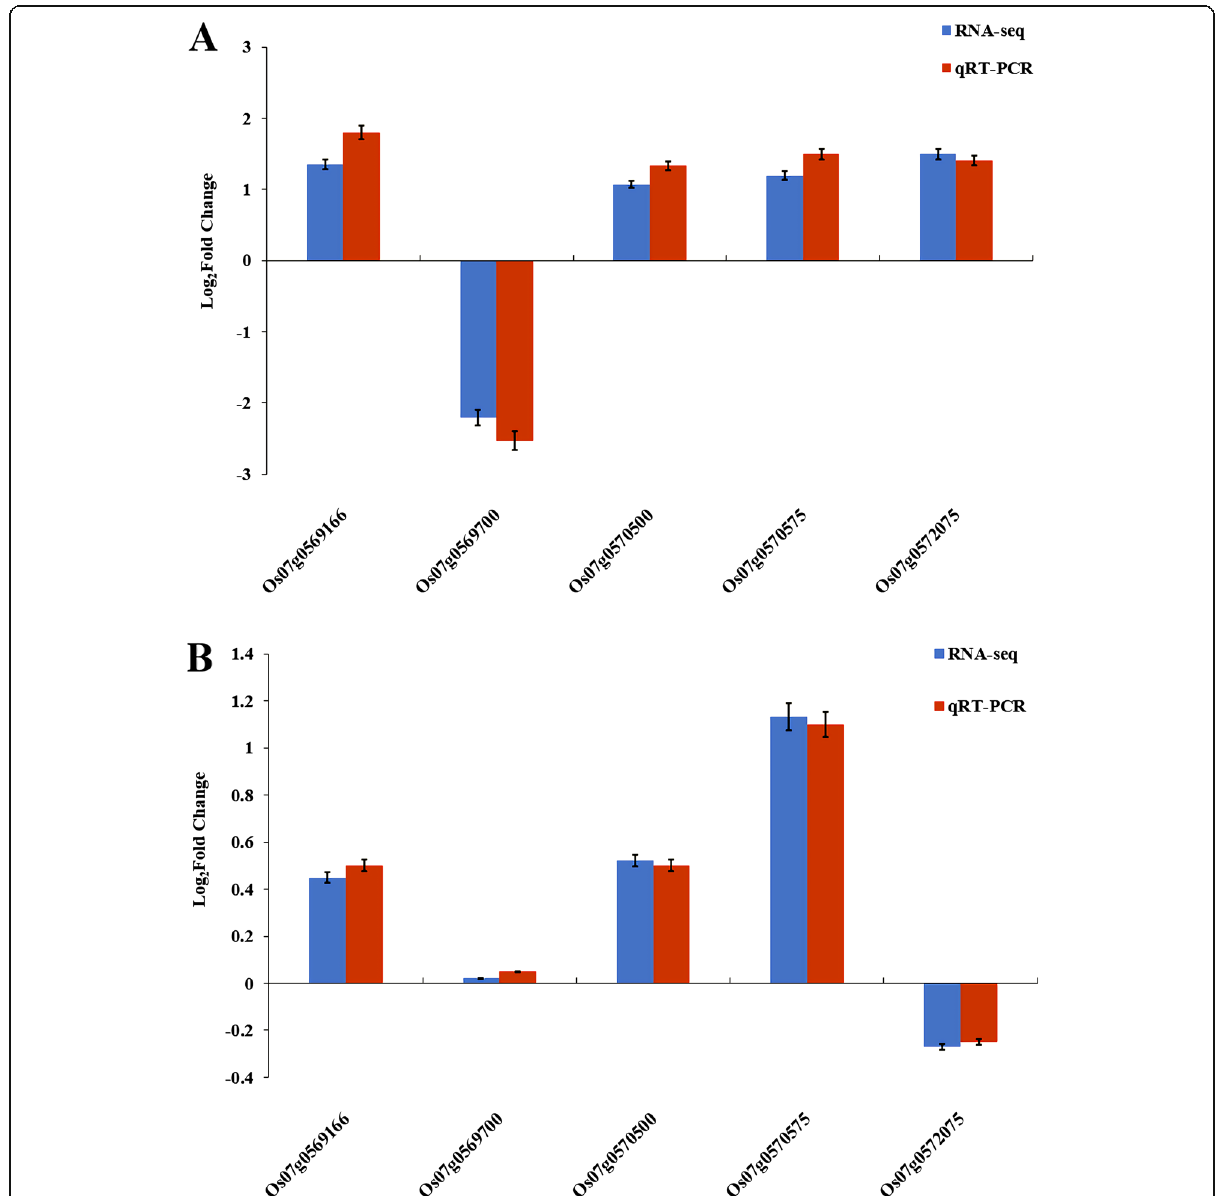
Fig. 8 Comparison of RNA-seq results and qRT-PCR analysis of gene expression levels. a Log 2 fold change of candidate genes in IR vs. TIR. b Log 2 fold change of candidate genes in WG vs. TWG. Blue and red block represent RNA-seq results and qRT-PCR analysis,